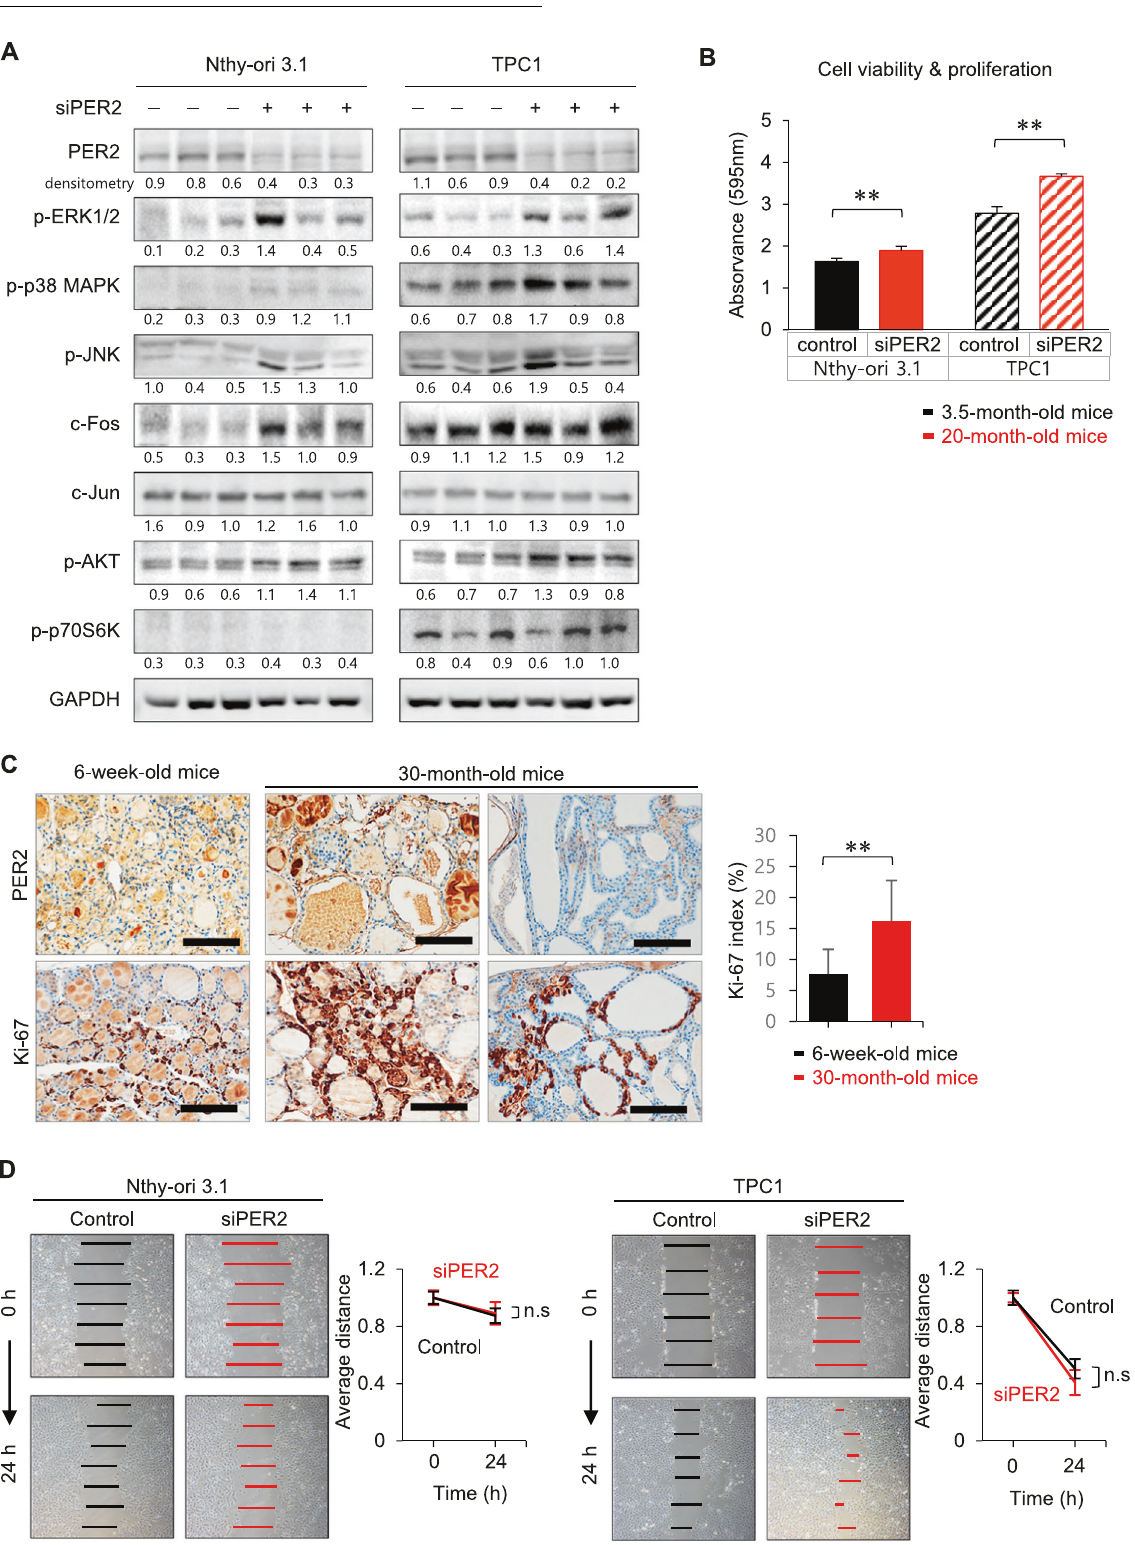
pathological outcomes of patients with PTC, we analyzed the relationship between PER2 expression and pathological para- meters in 90 PTCs (Table 2B). Patients with low PER2 expression were older than those with high expression ( p = 0.04). Lower PER2 levels were signi fi cantly associated with tumor multiplicity